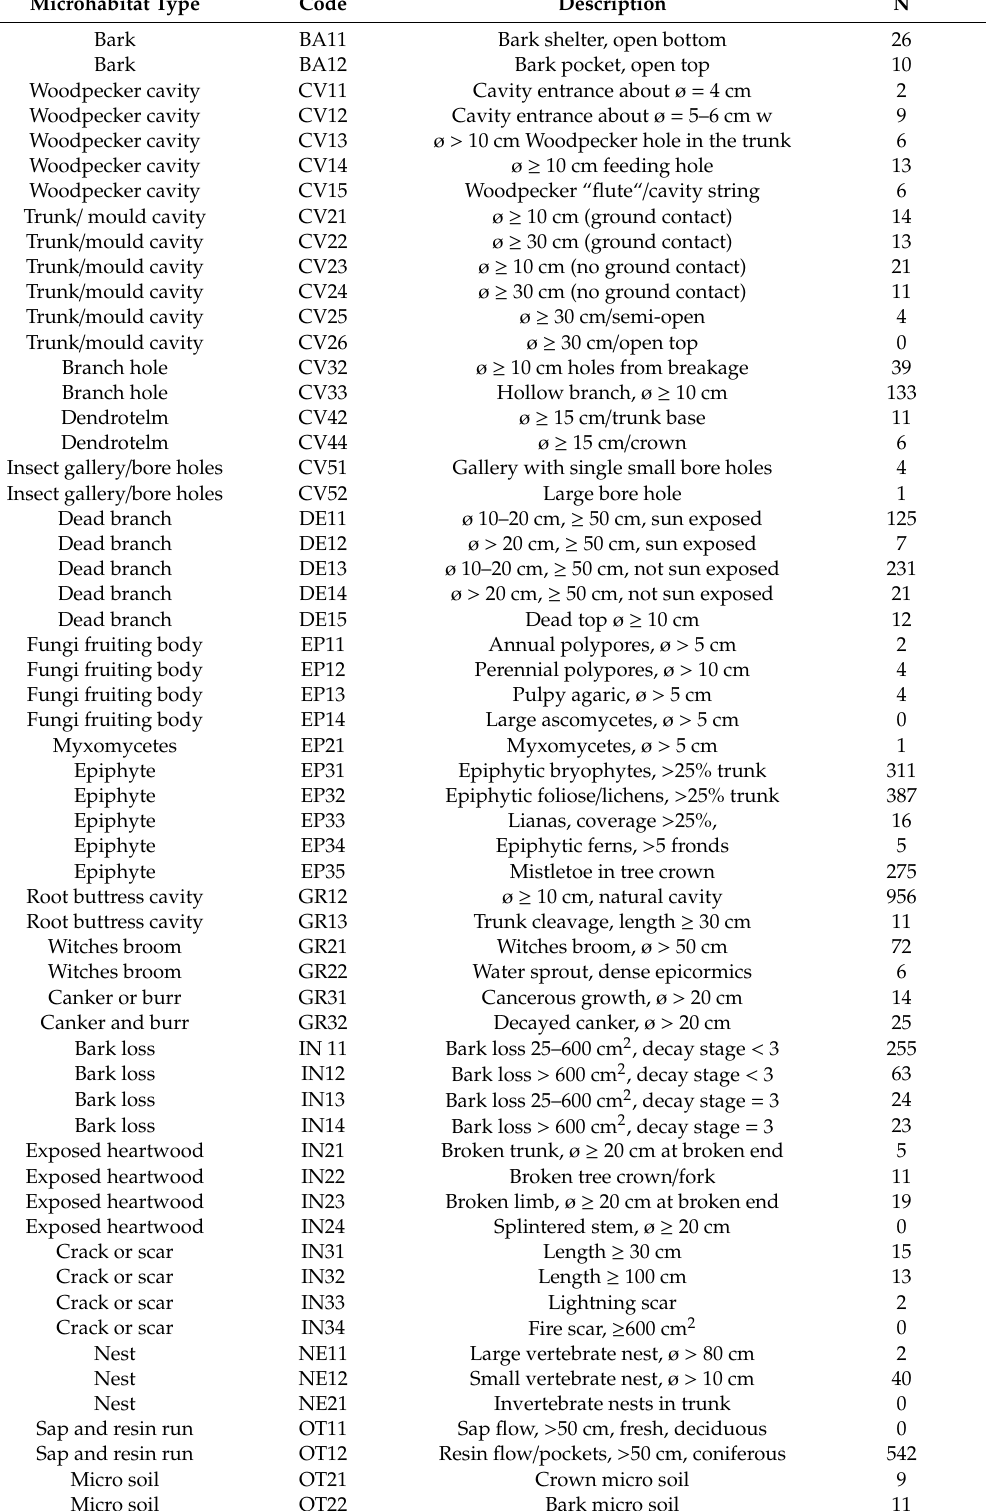
Table A1. Microhabitat type, detailed description and number of records from microhabitat